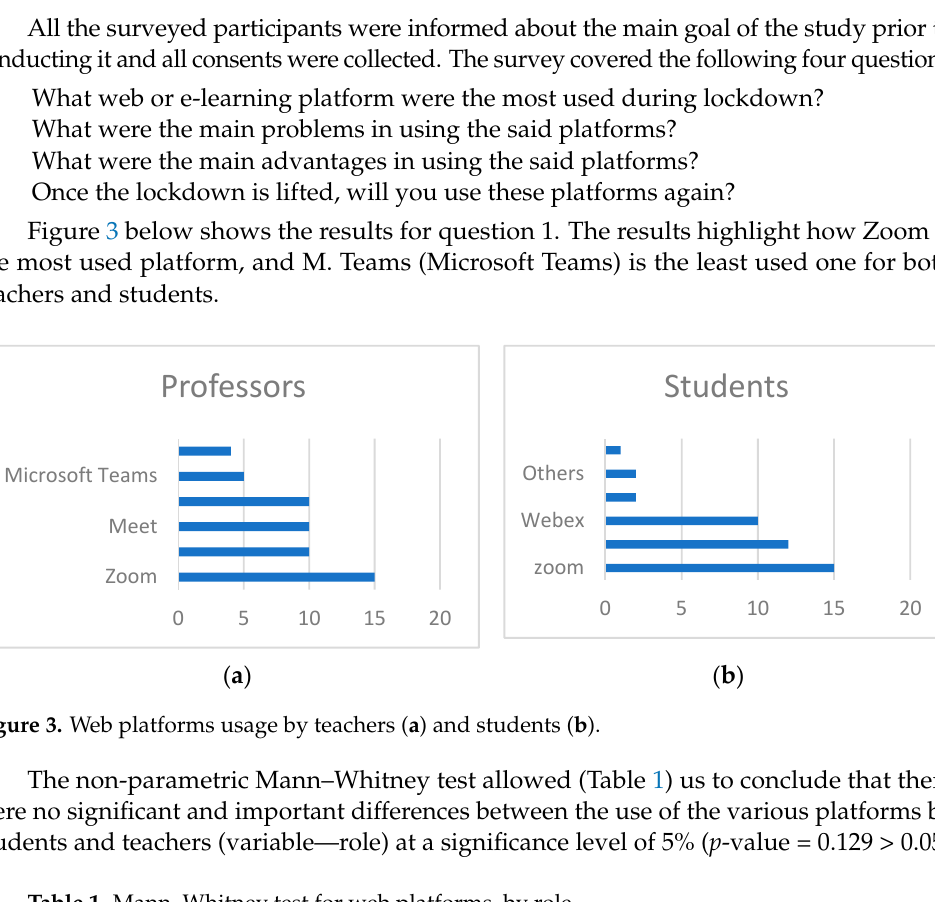
Figure 2. Student programs.